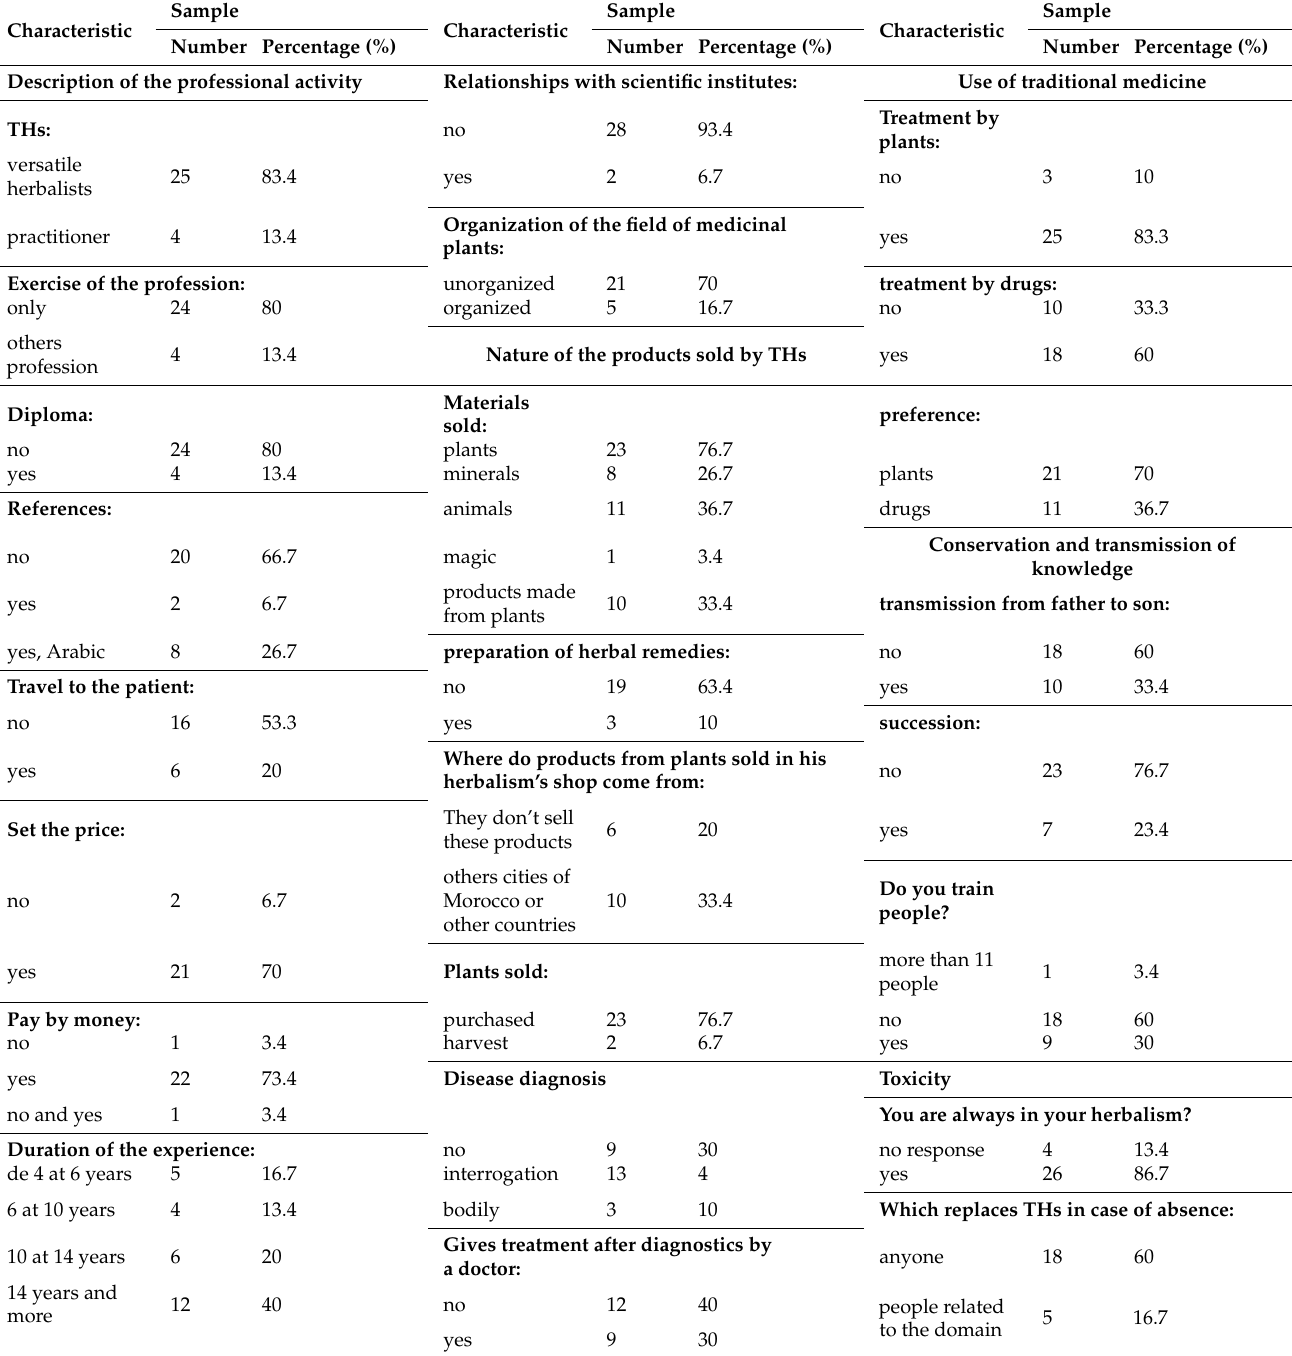
Table 2. Description of the professional activity of traditional healers